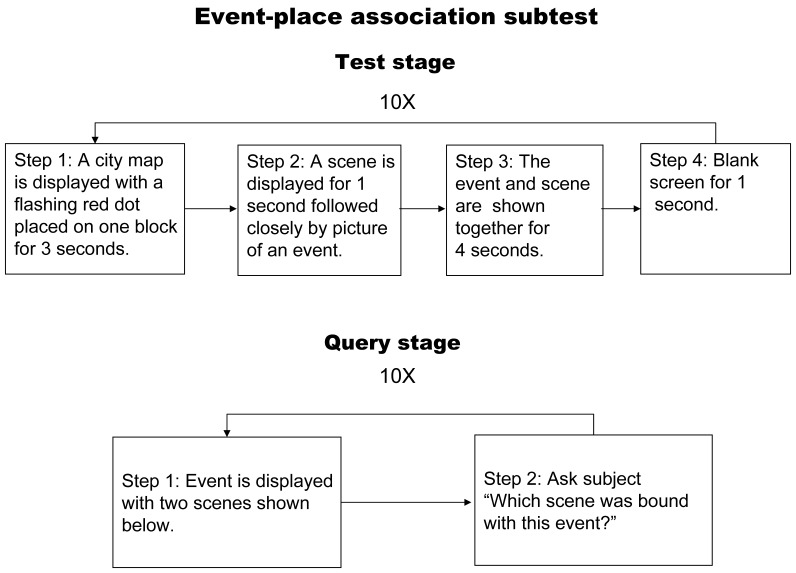
Flow chart illustrating the event-place memory test.